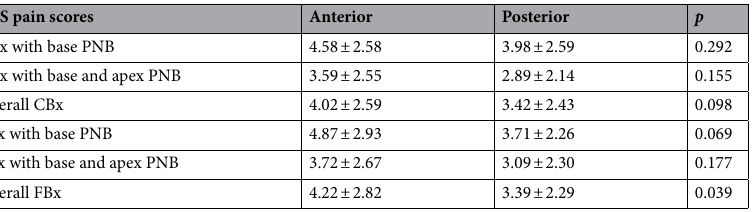
Table 3. Differences in mean VAS scores during various types of biopsies between the two groups according to biopsy sites. Data are expressed as mean ± SD. CBx magnetic resonance imaging cognitive target prostate biopsy, FBx magnetic resonance imaging/transrectal ultrasound fusion targeted prostate biopsy, PNB periprostatic nerve block, SD standard deviation, VAS visual analog scale.